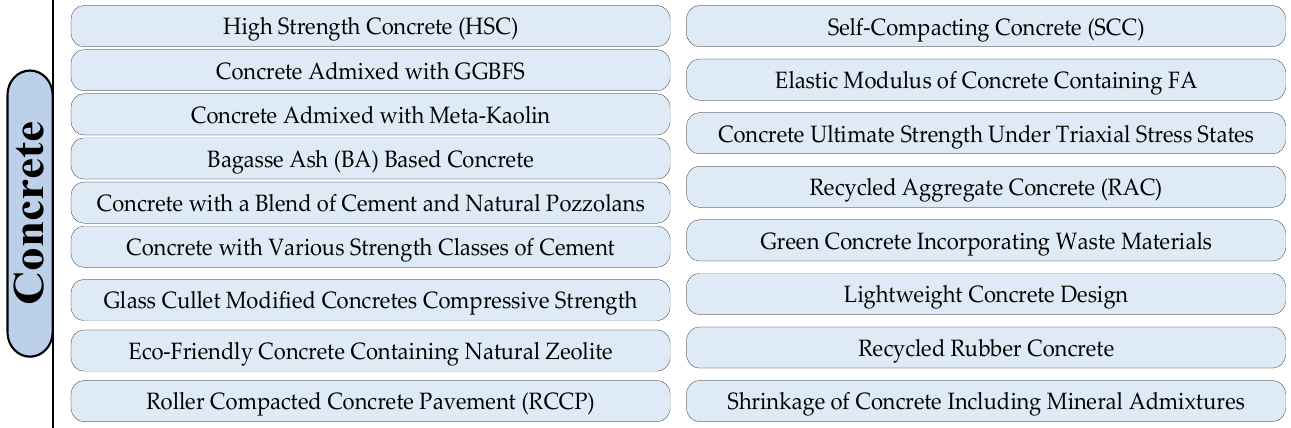
Figure 3. The studied subsections of concrete.